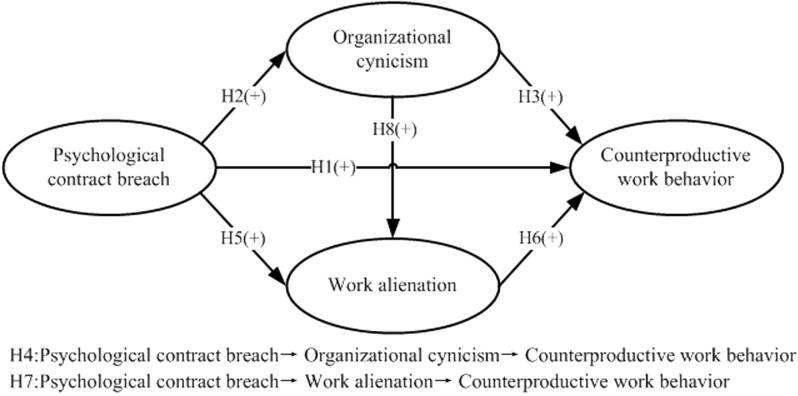
Hypothetical model.